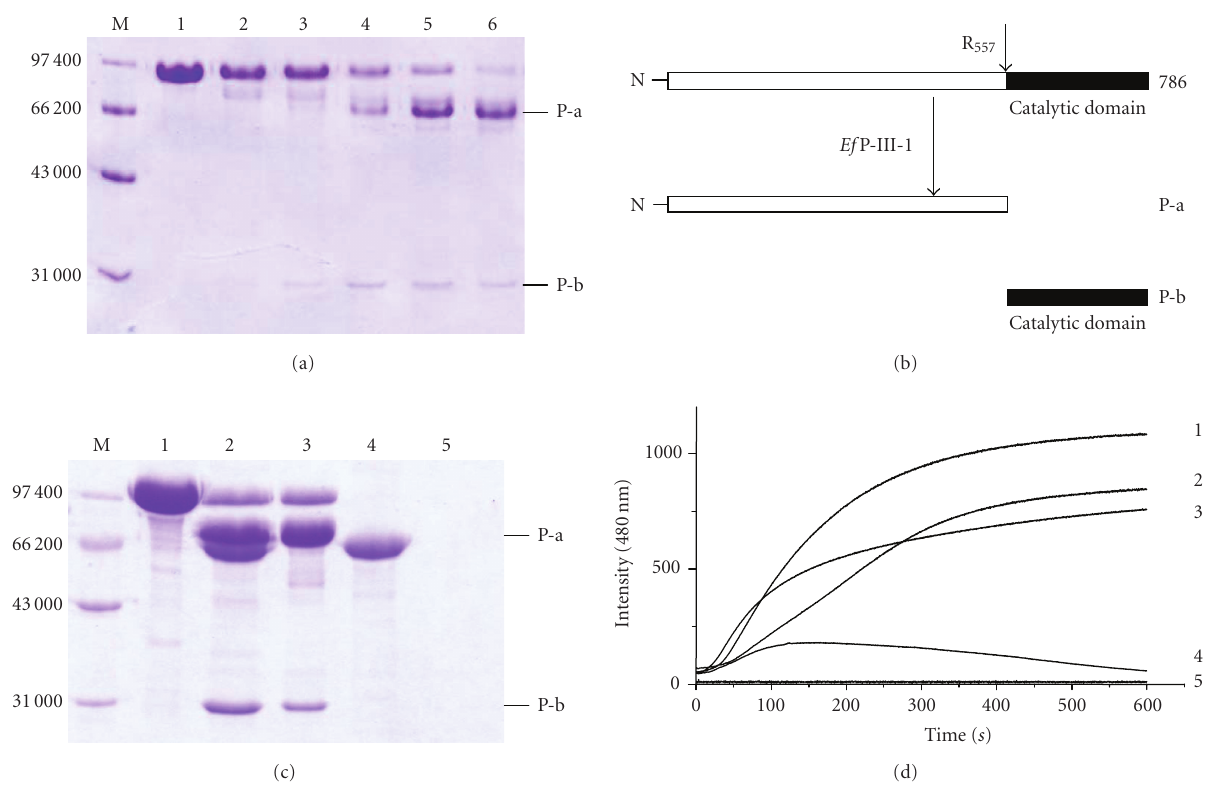
Figure 3: Activation of plasminogen by Ef P-III-1. Plasminogen (2mg/mL final concentration) dissolved in 50mM Tris-HCl bu ff er (pH 7.4) was incubated with Ef P-III-1 at 25 ◦ C. Aliquots were taken at di ff erent time intervals, and loaded on SDS-PAGE (12%) (a). M shows low-molecular-mass protein markers; lane 1: plasminogen as control; lanes 2 through 6 represented the hydrolyzed fragments after 2, 5, 15, 30, and 60 minutes. Cleavage of plasminogen after one-hour incubation with Ef P-III-1 at 25 ◦ C (b) represented the digested fragments P-a and P-b (catalytic domain or micropalsminogen). Plasminogen in the presence of tPA (0.1 μ M final concentration) was used as a control (c). Lanes 1 through 3: plasminogen alone, with tPA, or with Ef P-III-1; lane 4: tPA alone, and lane 5: Ef P-III-1 alone. Enzymatic activity was measured by light scattering assay (d). Thrombin was added to fibrinogen in the presence of Ef P-III-1 (curve 4, with plasminogen; curve 2, without plasminogen), and in the absence of Ef P-III-1 (curve 3 with plasminogen). Tris-HCl bu ff er (curve 5) was used as